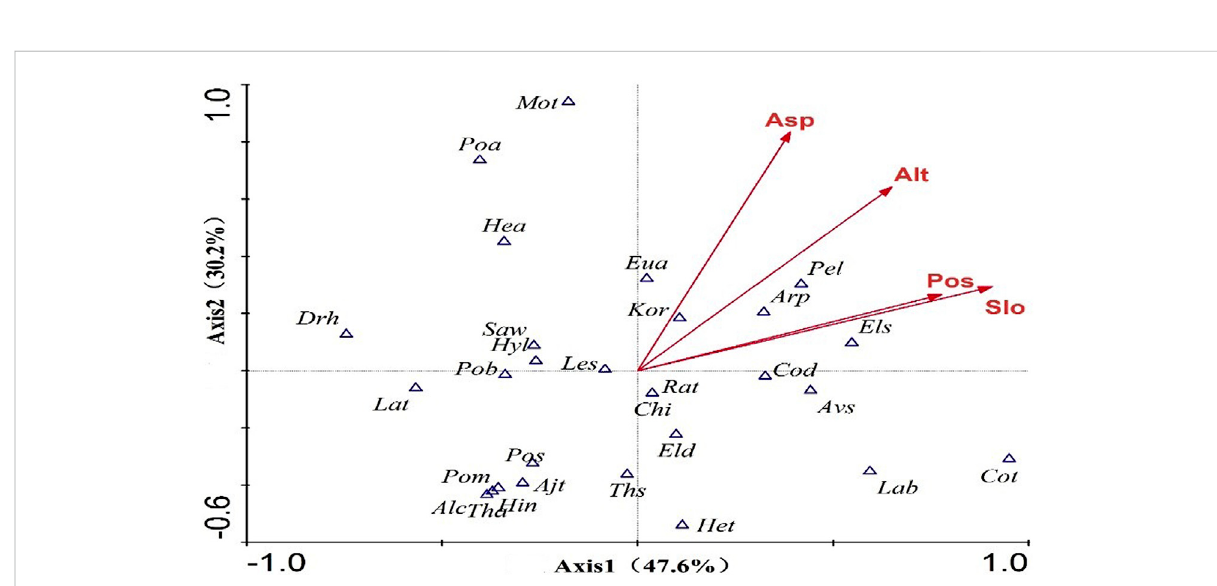
FIGURE 5 CCA two-dimensional ordination diagram for species and environmental variables of alpine grassland communities. Note: Arrows represent environmentalfactors,Asp:Aspect;Alt:Altitude;Pos:SlopePosition;Slo:Slopes.Trianglerepresentsplantspecies, Les:Leymussecalinus;Avs:Avena sativa; Els:Elymus sibiricus; Eld: Elymus dahuricus; Poa:Poa annua; Saw:Saussurea woodiana; Hea:Heteropappus altaicus; Ajt:Ajania tenuifolia; Lab: Lagotis brevituba; Pel:Pedicularis longi fl ora; Lat:Lancea tibetica; Cod:Corispermum declinatum; Chi:Chenopodium iljinii; Pos:Polygonum sibiricum; Pom:Polygonum macrophyllum; Het:Hedinia tibetica; Arp:Arabis pendula; Tha:Thalictrum alpimun; Drh:Dracocephalum heterophyllum; Eua:Euphorbia altotibetica; Pob:Potentilla bigurca; Mot:Moicroula tangutica; Alc:Allium cyaneum; Kor:Kobresia royleana